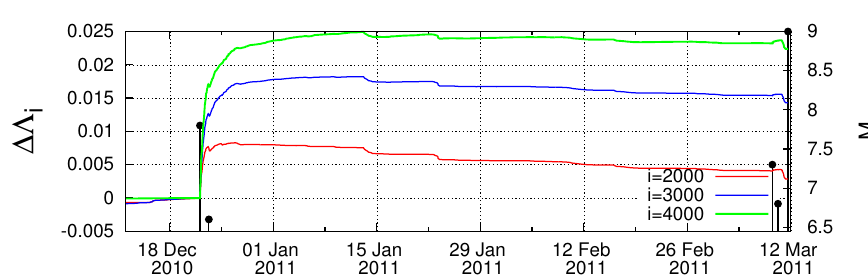
Figure 15. An almost three-month excerpt of Figure 14 in expanded time scale showing the change ∆Λ Λ i of i values versus the conventional time after the M 7.8 EQ on 22 December 2010 at 27.05 143.94 ◦ E. After the M 7.3 foreshock on 9 March 2011, a decrease of the ∆Λ i is evident. The vertical lines ending at black solid circles show the magnitudes ( M ≥ 7) of EQs, which are read in the right scale. Taken from Ref. [87].